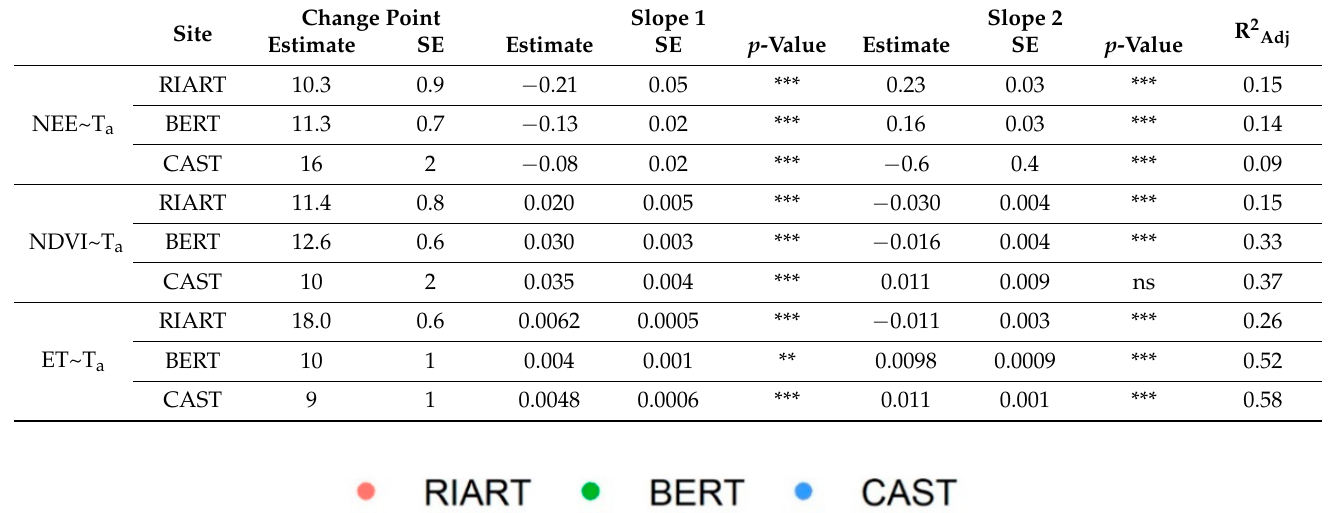
Table 2. Segmented linear models results for each site: net ecosystem exchange (NEE) as function of ambient temperature (T a ); normalized vegetation index (NDVI) as function of T a ; evapotranspiration (ET) as function of T a . Models’ estimate, standard error (SE), and p -value (Pr (>|t|)): ‘***’ p < 0.001, ‘**’ p < 0.01, not significant (ns) p > 0.05.